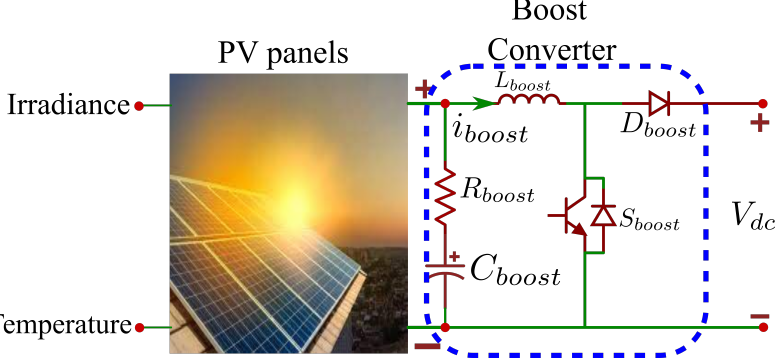
Figure 8. Representation of the PV power system supply to the